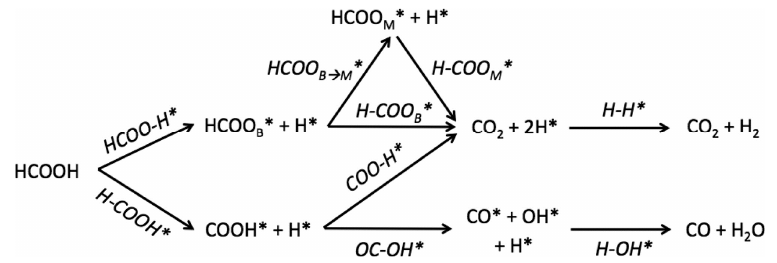
Figure 9. Reaction mechanism of FA decomposition. Reprinted with permission from [104].